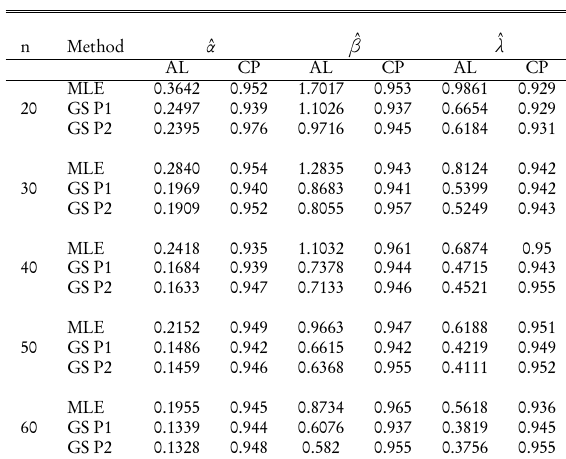
Average length (AL) and coverage probability (CP) of 95% asymptotic confidence / HPD credible intervals of parameters when α = 0.5, β = 1.5, λ =